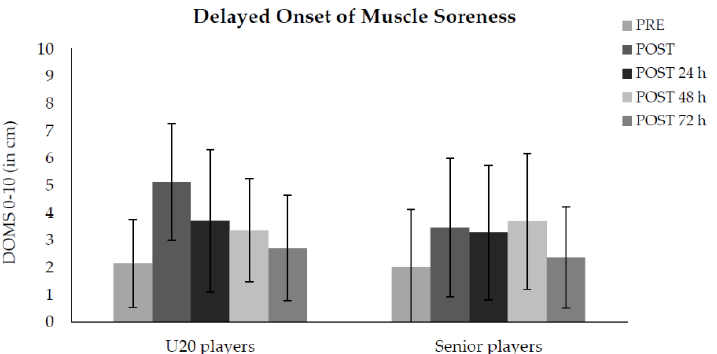
Figure 4. Mean DOMS value (in cm) as a function of measurement time point (PRE, POST, POST 24 h, POST 48 h, POST 72 h) for U20 and senior handball players. The error bars represent stand- ard deviations.